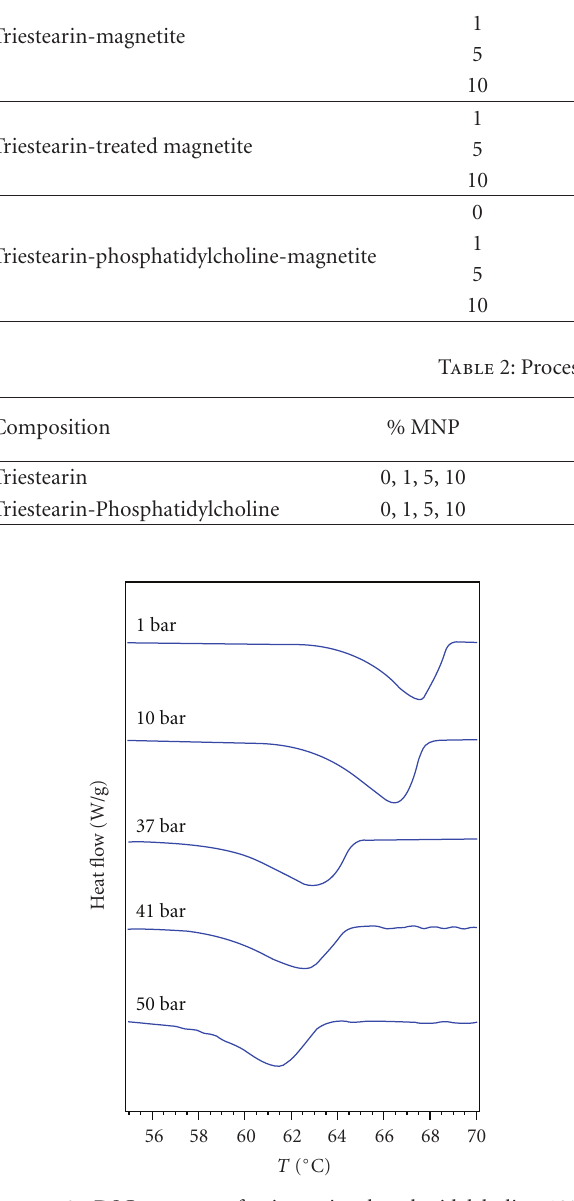
Figure 3: DSC spectra of triestearin-phosphatidylcholine-10% (w/w) magnetite mixture as a function of